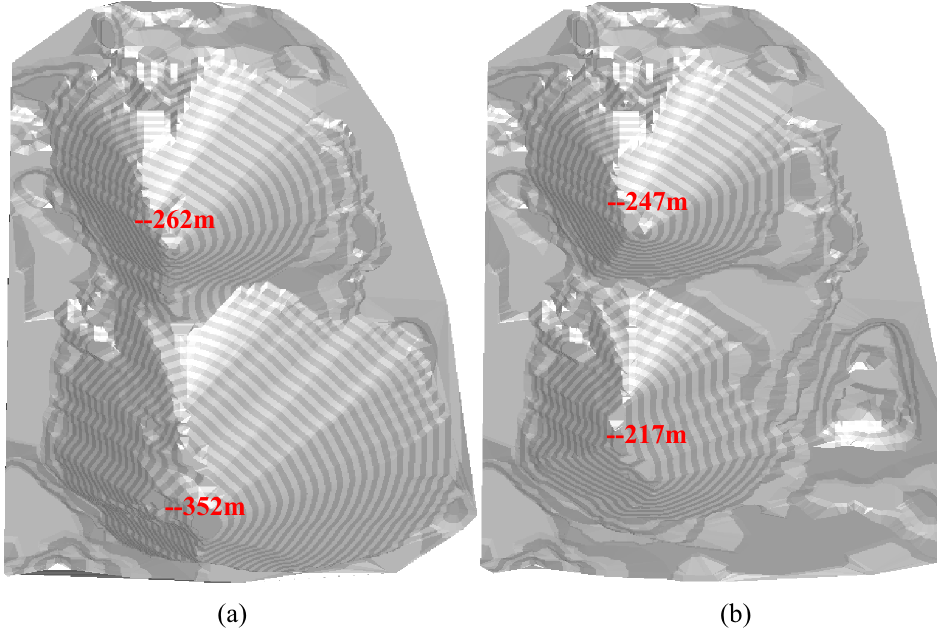
Figure 11. Pit status in the 5th year of the production scheduling with production capacity of 50.31 million tons ( a ) and 24.2 million tons ( b )